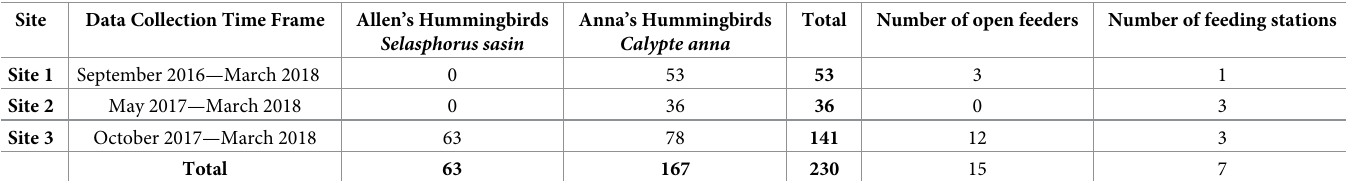
Table 2. Number of hummingbirds PIT tagged at Sites 1 and 2 in Northern California and Site 3 in Southern California. Open feeders are defined as feeders that did not have radiofrequency identification equipment. Feeding stations are defined as those equipped with radiofrequency identification equipment to detect passive inte- grated transponders.